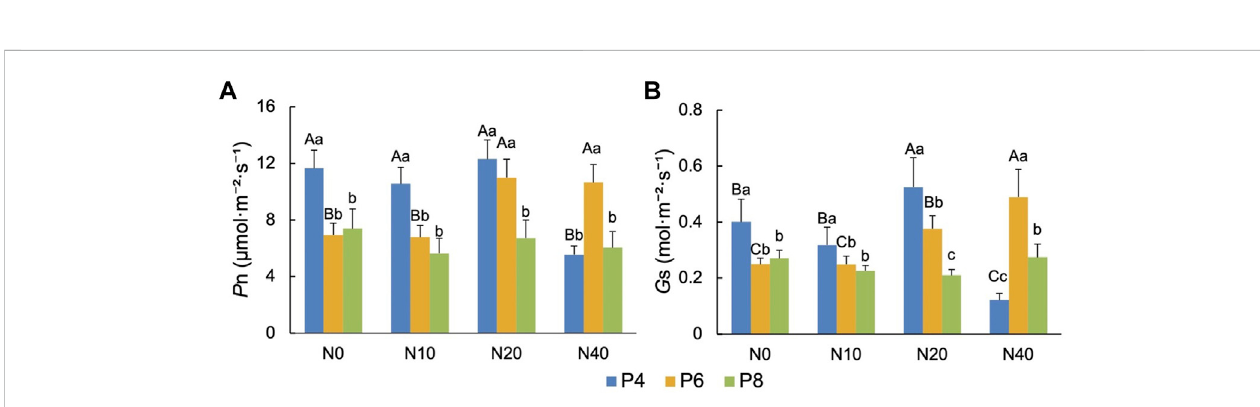
FIGURE 4 Effects of N and P addition on (A) net photosynthetic rate ( Pn ) and (B) stomatal conductance (Gs) of P.tanacetifolia